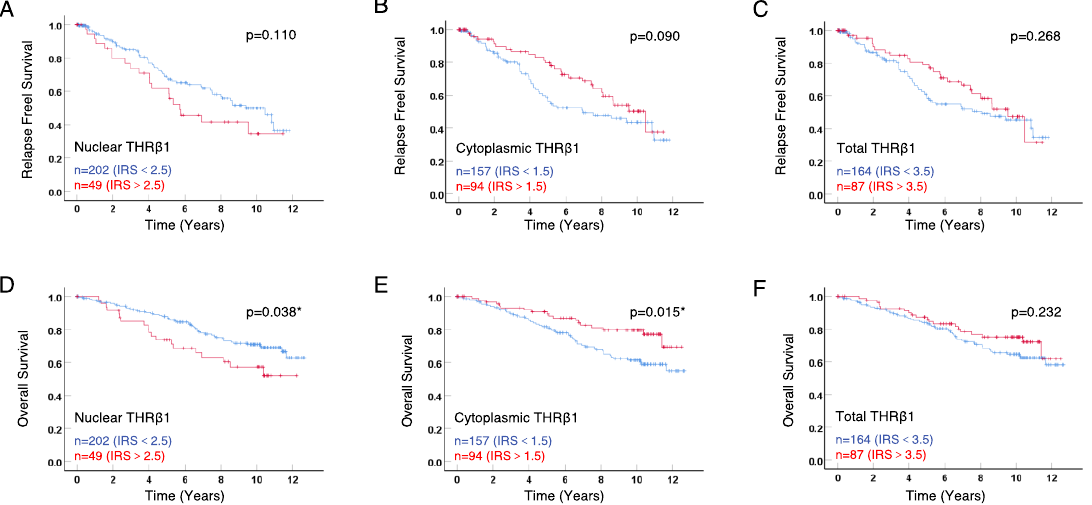
Figure 2. Kaplan–Meier survival analyses according to nuclear, cytoplasmic, and total THRβ1 expression. Relapse free survival (RFS) ( A – C ) and overall survival (OS) ( D – F ) curves are presented according to THRβ1 expression—either nuclear ( A , D ), cytoplasmic ( B , E ), or total ( C , F ) expression. Optimal IRS cut-off values and number of cases for each group are indicated in each graph. Statistical significance is shown as p -value from log-rank test (* p < 0.05).